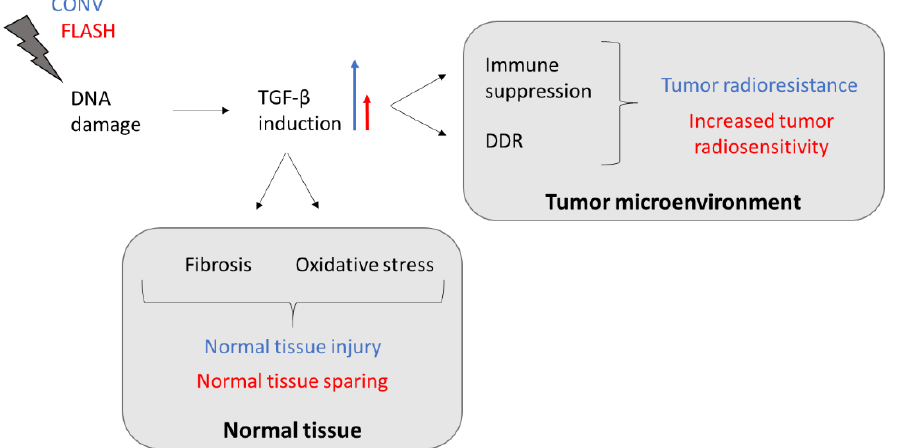
Figure 1. TGF- β -induced tumor resistance and normal tissue injury following CONV RT might be reduced by FLASH-dose-rate irradiation. The blue long arrow indicates a great induction (CONV) and the red short arrow indicates a decreased induction (FLASH). Abbreviations: TGF- β , transforming growth factor beta; DDR, DNA damage response.